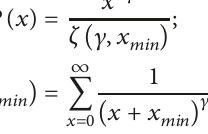
Figure 3: Power law relationships of the total number of tweets, retweets, and mentions per day as a function of the number of unique users that participated in the conversation each day for the 2015 campaign (top) and the 2016 campaign (bottom). Note that the data corresponding to the day of the elections (marked with a circle) were not included in the